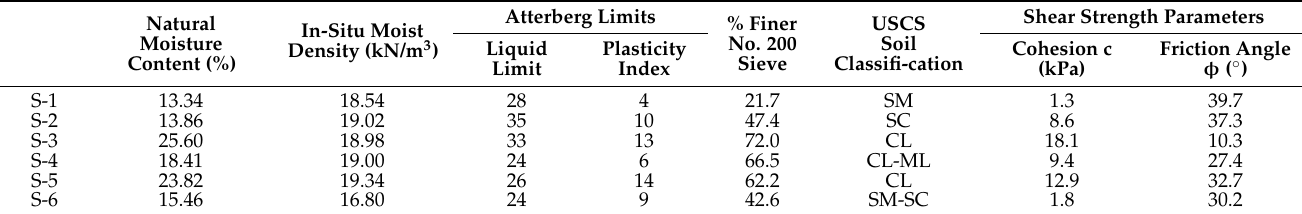
Table 2. Index and engineering properties of soil samples collected from each of six landslide slopes (S-1 through S-6; see Figure 2). Natural Moisture